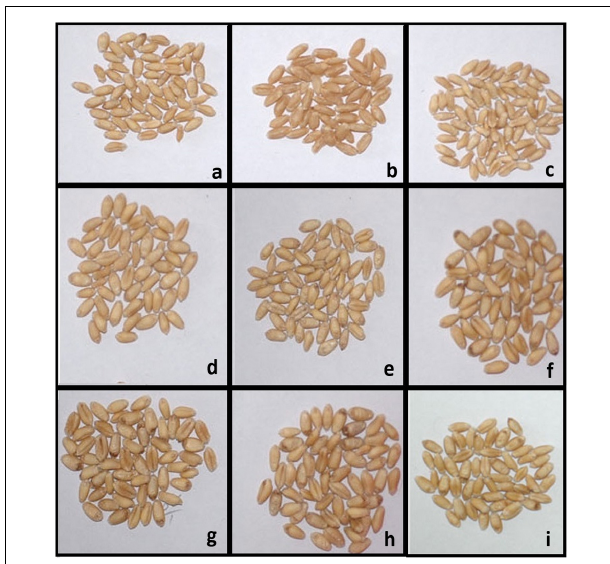
FIGURE 3 | Representative grains from the field grown BC 2 F 5 progenies along with parental genotypes. (a) PBW343. (b) Rye selection 111. (c–i) BC 2 F 5 progenies obtained from cross of PBW343/Rye selection 111.